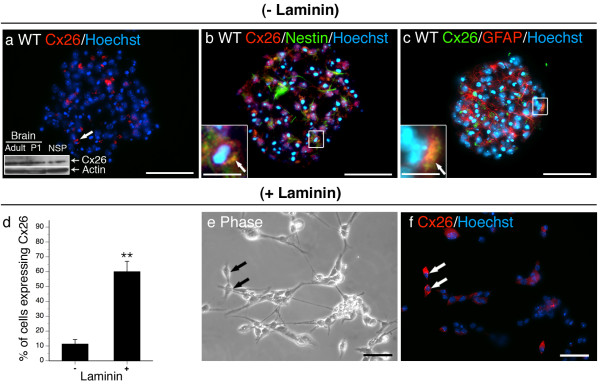
Cx26 is expressed Type 1 and Type 2a NPCs and is responsive to laminin. Cx26 was expressed by a small population of cells within neurospheres (a, arrow) and localizes to both cells expressing nestin (b, inset and arrow) and GFAP (c, inset and arrow). Inset in (a) depicts western blotting on protein derived from adult, P1 and neurospheres cultured in the absence of laminin to confirm antibody specificity. A marked increase in the frequency of Cx26+ cells was detected when cultured on laminin (d, e, f, arrows). Data represent mean of 5–15 sections (- laminin) or field (+ laminin) counted over n = 5–10 cultures/condition ± SEM. (d). Scale bars, 50 μm, insets, 25 μm. **p < 0.01 Student's t-test.